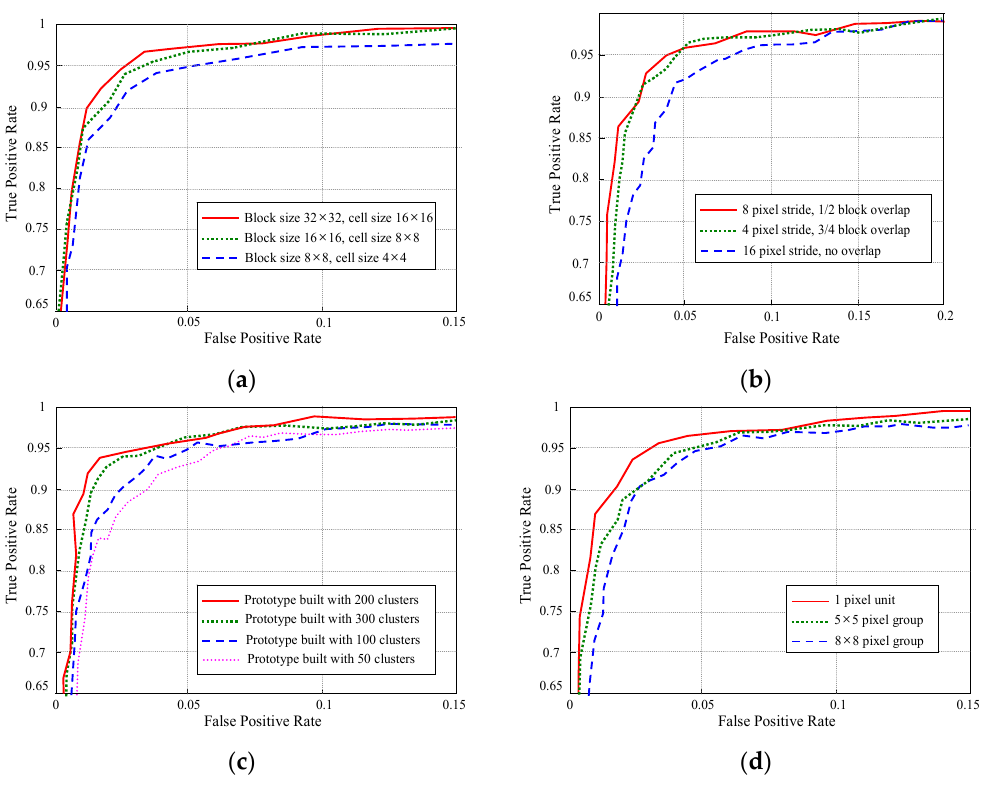
Figure 22. Far-field model performances with respect to the important model parameters. ( a ) Far-field model performances in different block sizes of the appearance prototype; ( b ) Far-field model performances in different matching strides; ( c ) Far-field model performances using different prototype sizes; ( d ) Far-field model performances in different block sizes of the spatial prototype.